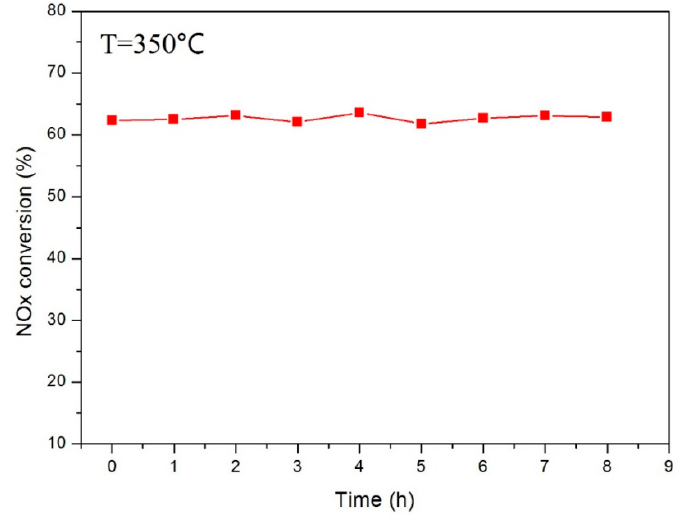
Figure 15. The activity of wire-mesh catalysts under continuously mixed gas.